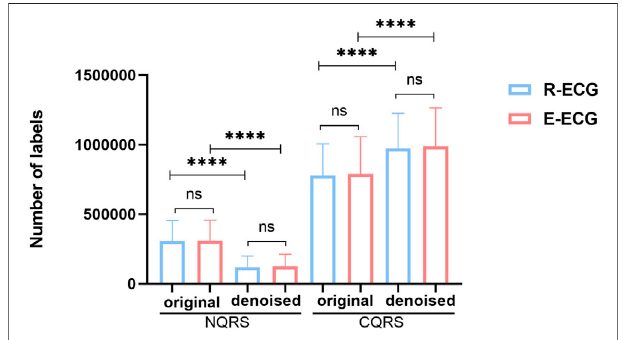
FIGURE 7 | The distribution of NQRS and CQRS before and after denoising in R-ECG and E-ECG datasets. Data are expressed as mean ± SD. The difference between un-denoise and denoise groups was analyzed by paired t -test, and the difference between R-ECG and E-ECG was